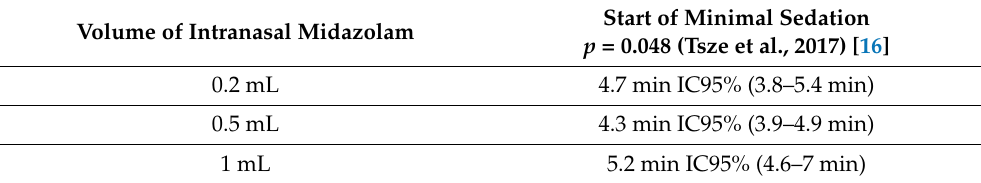
Table 6. Starting sedation with different volumes of intranasal Midazolam. Volume of Intranasal